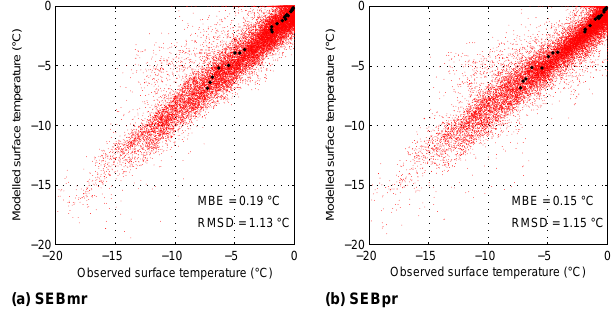
Figure 3. Observed versus modelled surface temperature for (a) SEBmr and (b) SEBpr runs. Red dots are 30min averages, while black dots are monthly averages.